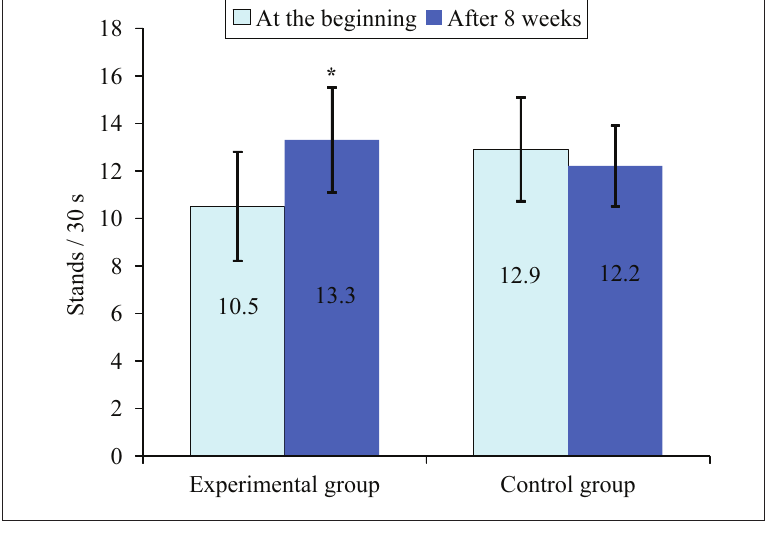
Figure 3. 30 s arm curl test results in the experimental group at the beginning and after an Figure 4. 30 s chair stand test results at the beginning and after 8-week period in the experimental and control groups